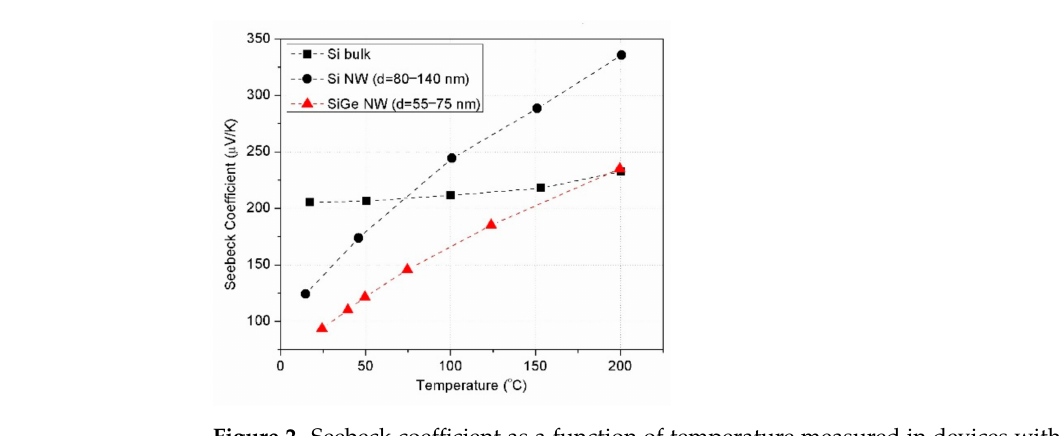
Figure 2. Seebeck coefficient as a function of temperature measured in devices with Si NWs legs, SiGe NWs legs, bulk Si legs bridging the suspended platform and its surrounding Si